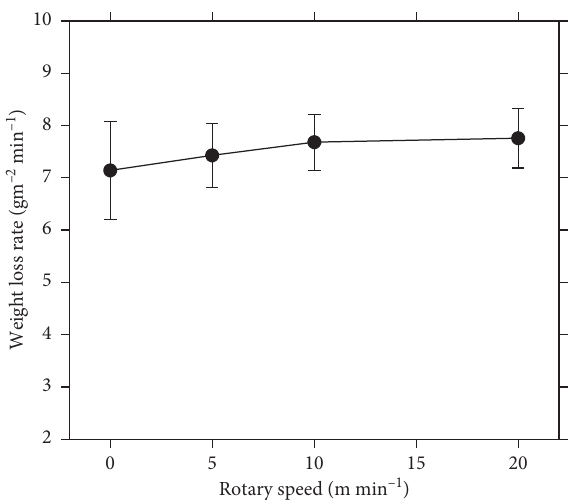
Figure 8: The static pickling rate in 300gL − 1 H 75 ° C with different iron ions.